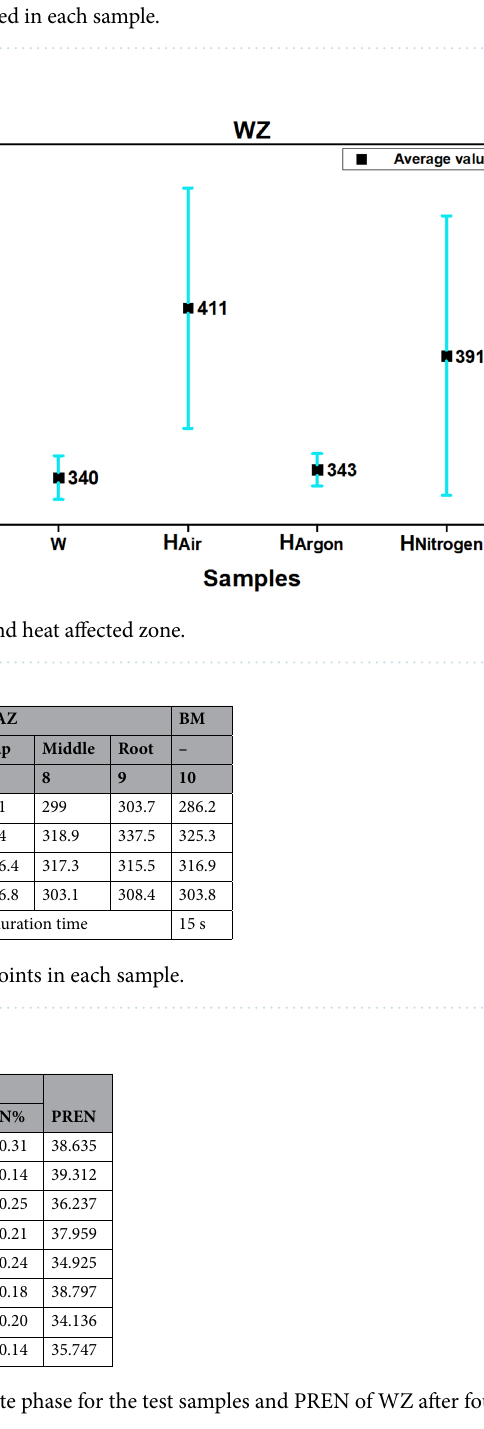
Figure 19. The zones where the hardness was measured in each sample.